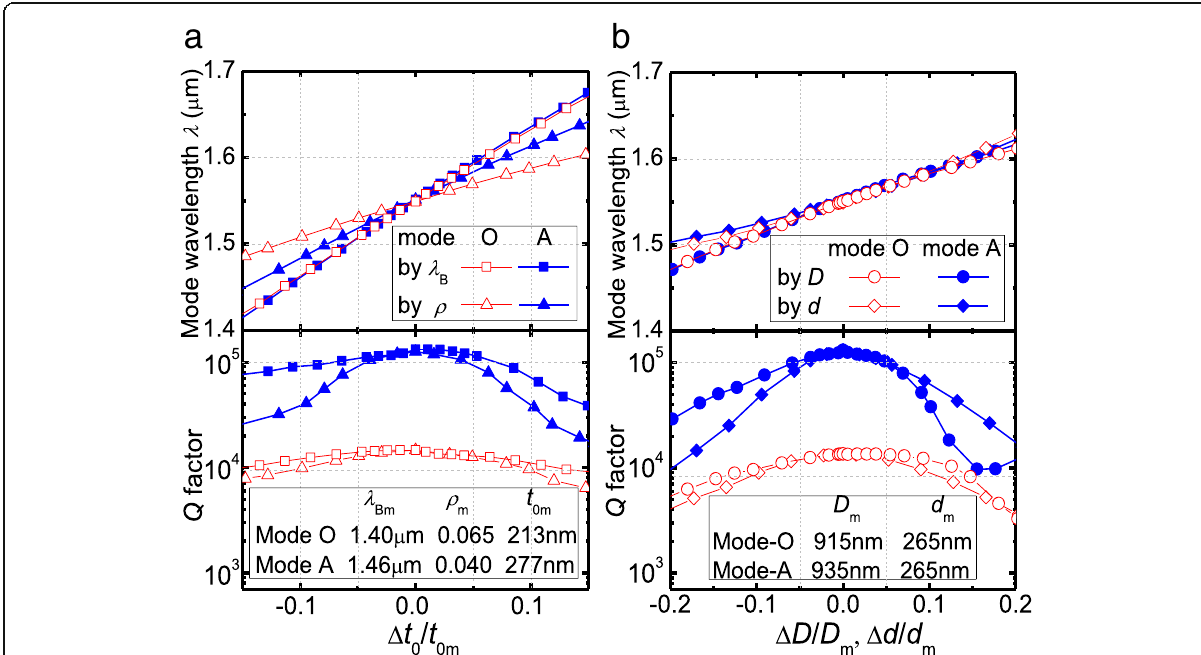
Fig. 3 Varying mode wavelength λ and Q factor as the a vertical and b lateral sizes deviate from the optimized conditions for both modes O and A. Note that the vertical sizes, i.e., the layer thicknesses, are tuned by λ B or ρ but displayed in terms of the spacer thickness t 0 . The lateral sizes are tuned by cavity diameter D or air-aperture diameter